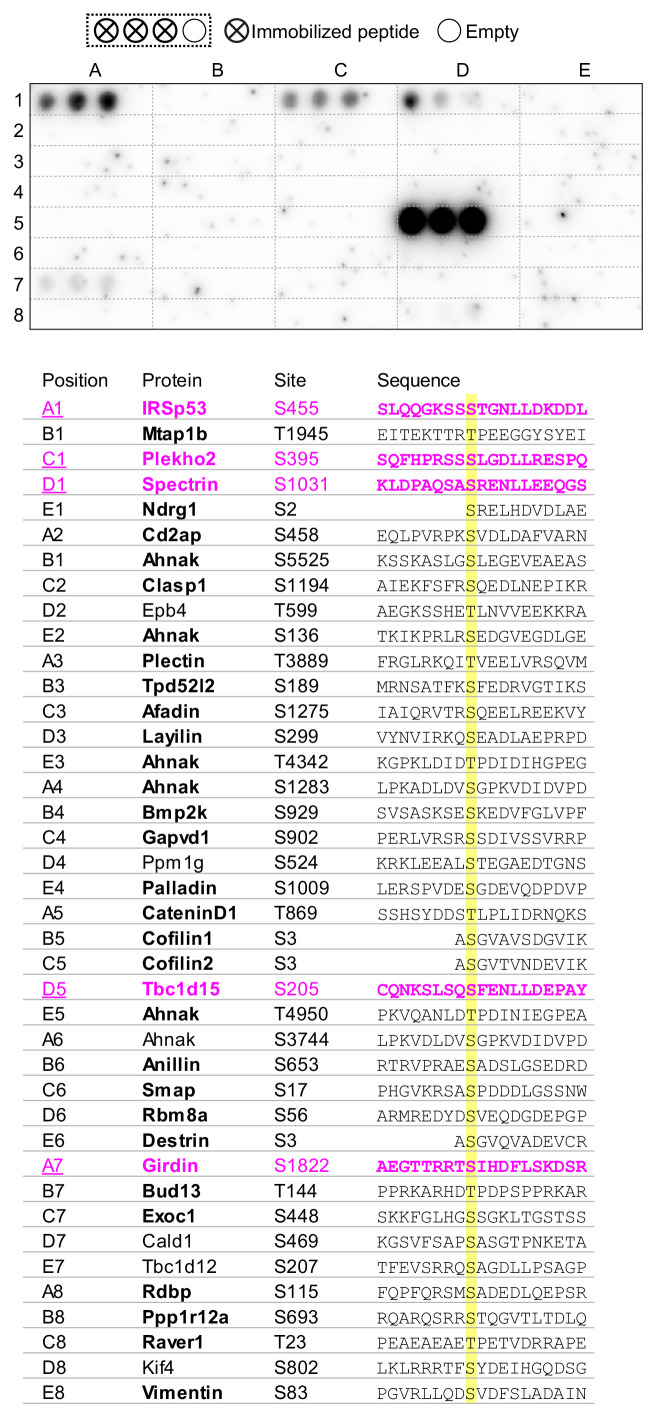
Binding of candidate Phactr1/PP1 substrates in the peptide array overlay assay.19-mer unphosphorylated peptides from the indicated substrates were arrayed in triplicate as shown and tested for their ability to recruit GST-Phactr1(516-580)/PP1 from solution. Visualisation was with anti-GST antibody.